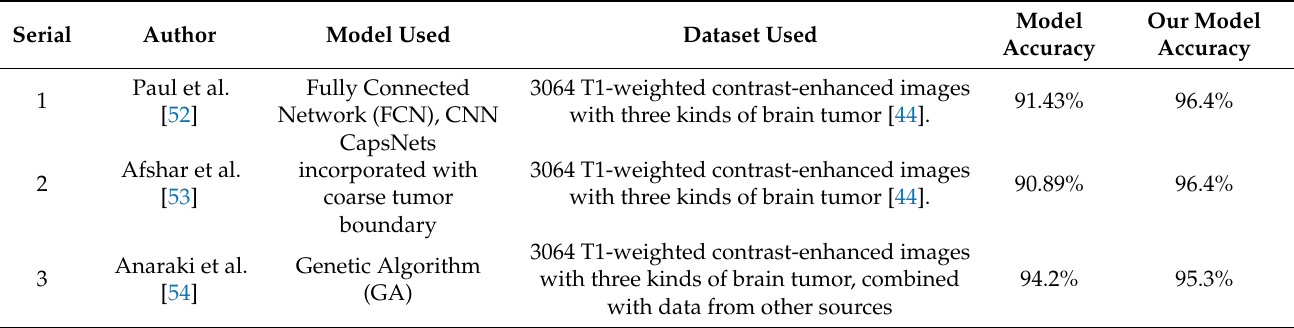
Table 5. Comparison of the proposed structure with existing